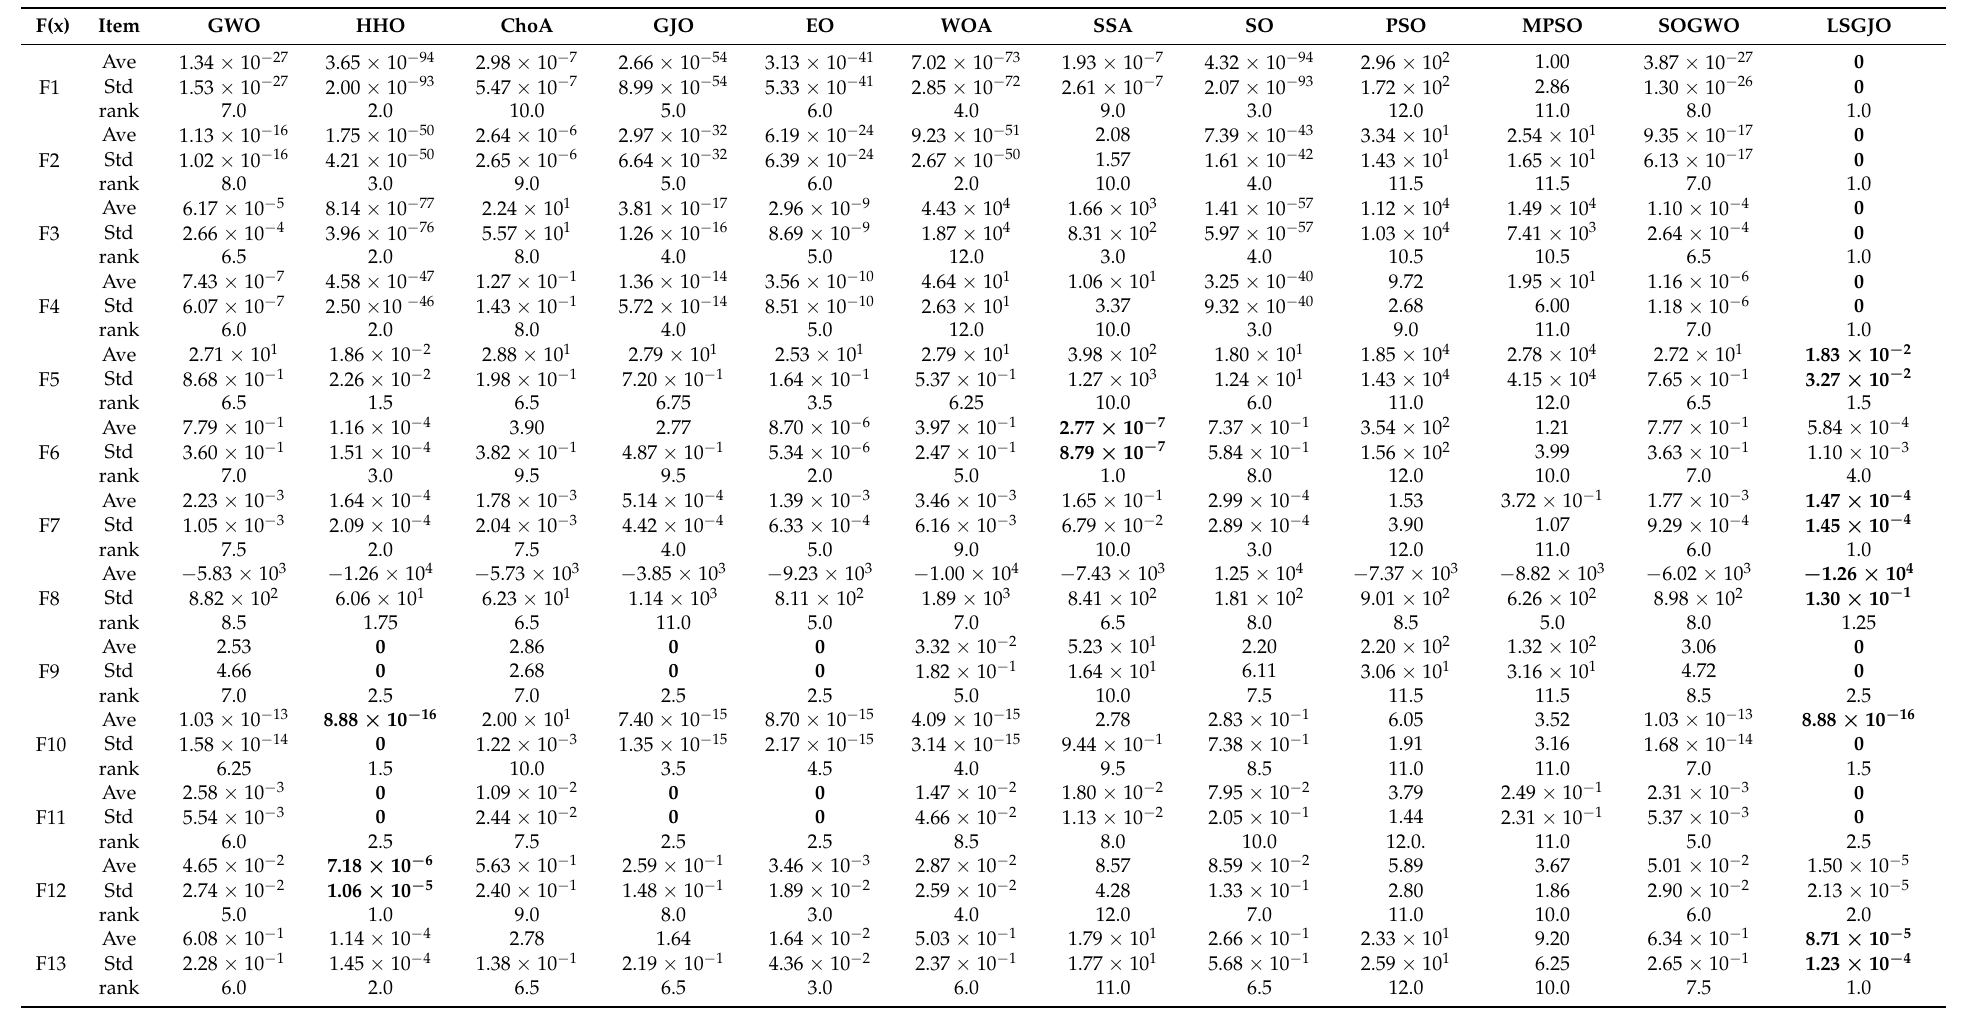
Table 3. Results and comparison of different algorithms on 23 benchmark functions with Dim = 30. The best results of the experiments are shown in